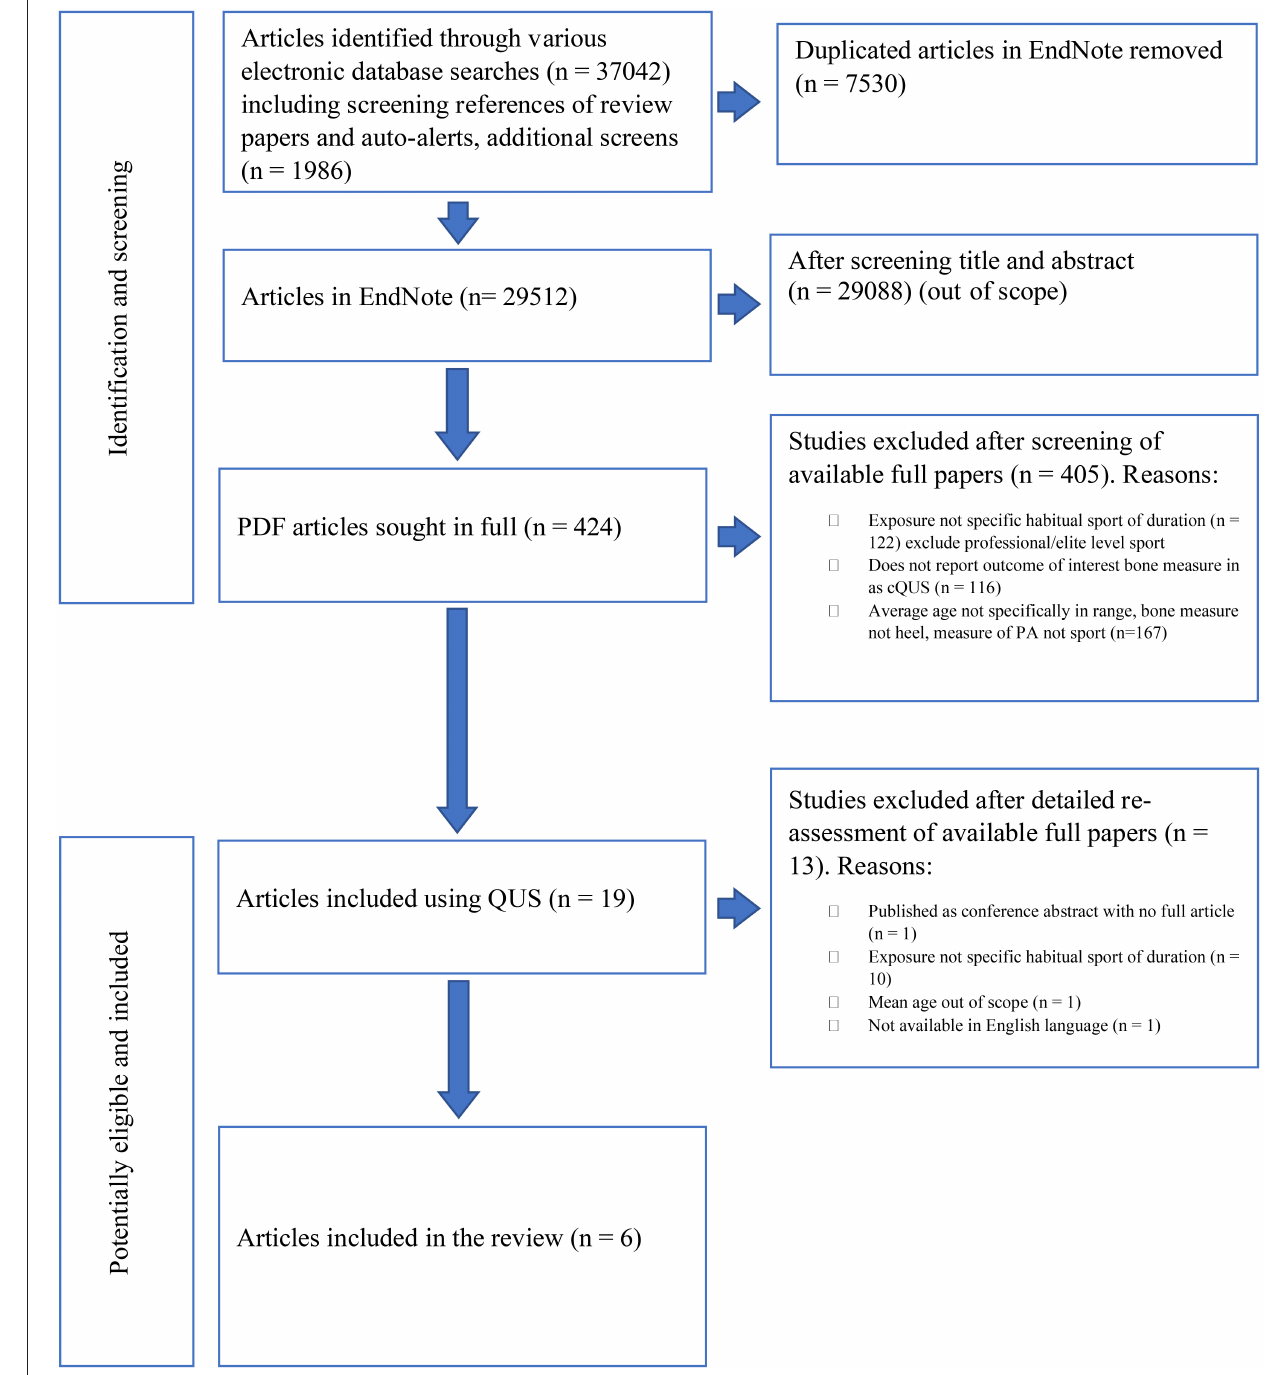
FIGURE 1 | Flowchart of the literature search and the study selection process.